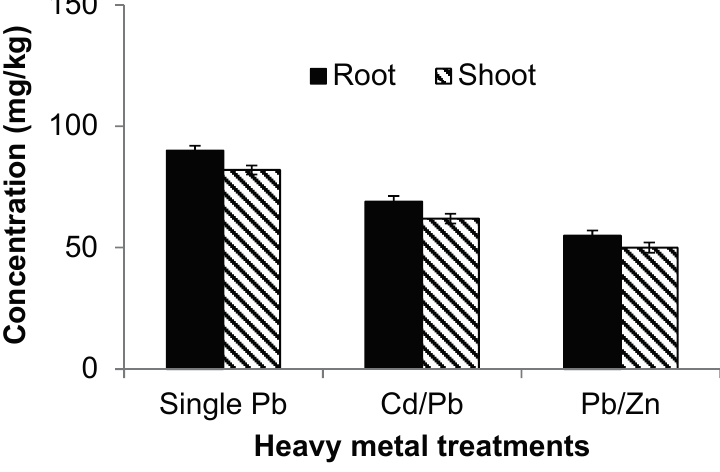
Figure 4. Comparison of lead (Pb) uptake subject to different